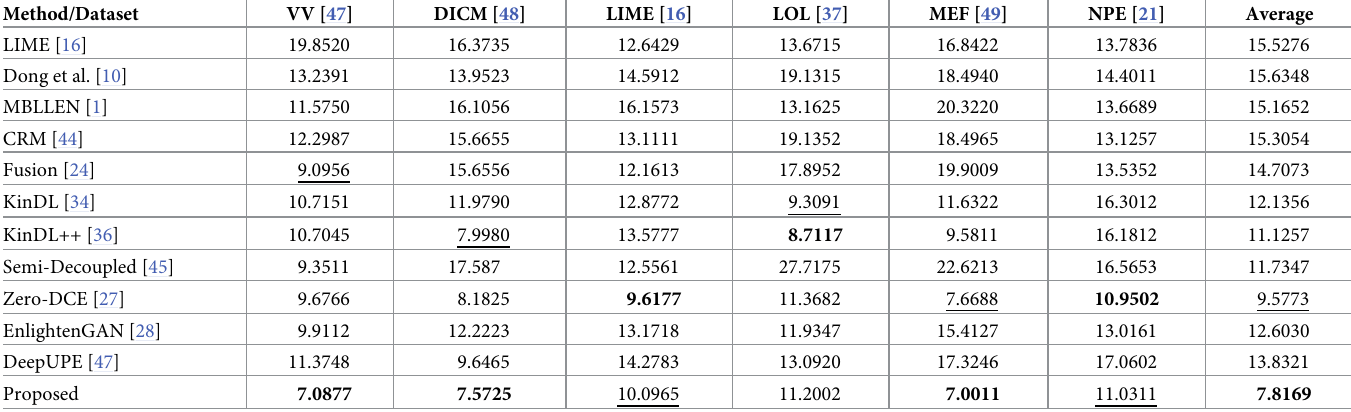
Table 2. Perception Image Quality Evaluator (PIQE) comparison between nine low light enhancement methods on six different datasets. Best score is in bold and sec- ond best is underlined.